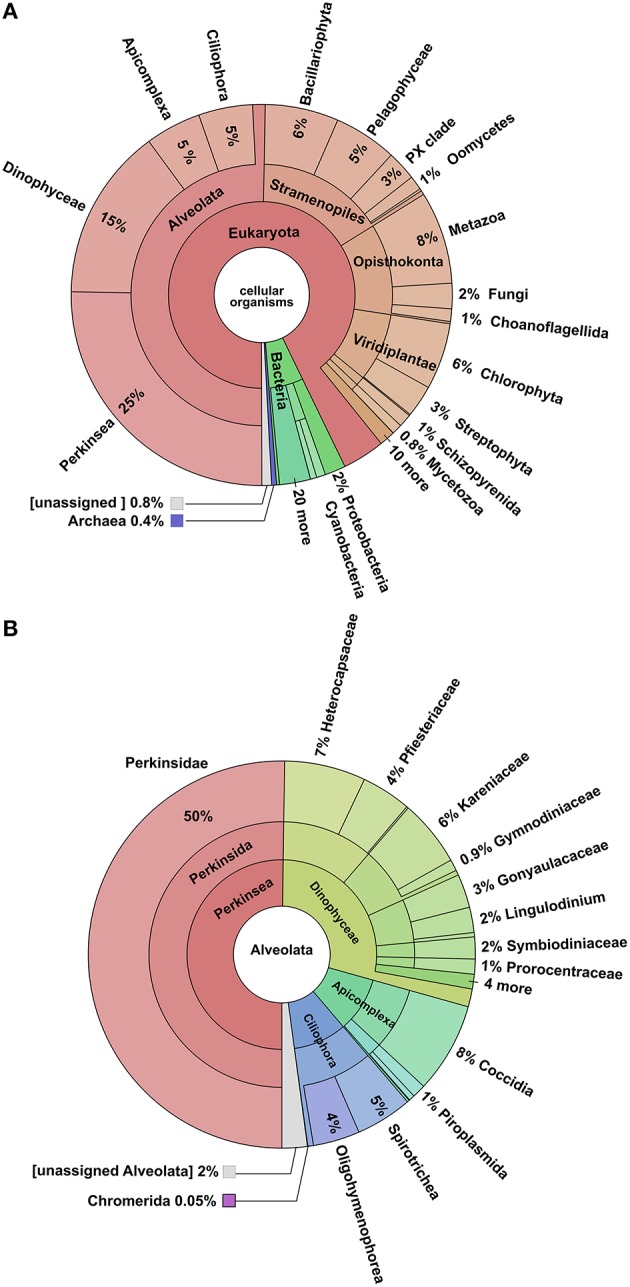
Krona Plots of the blastx-hits. (A) Distribution of all blast hits, showing that the majority was assigned to the Alveolata. (B) Hits within the Alveolata, showing that most reads were assigned to the Perkinsus marinus.